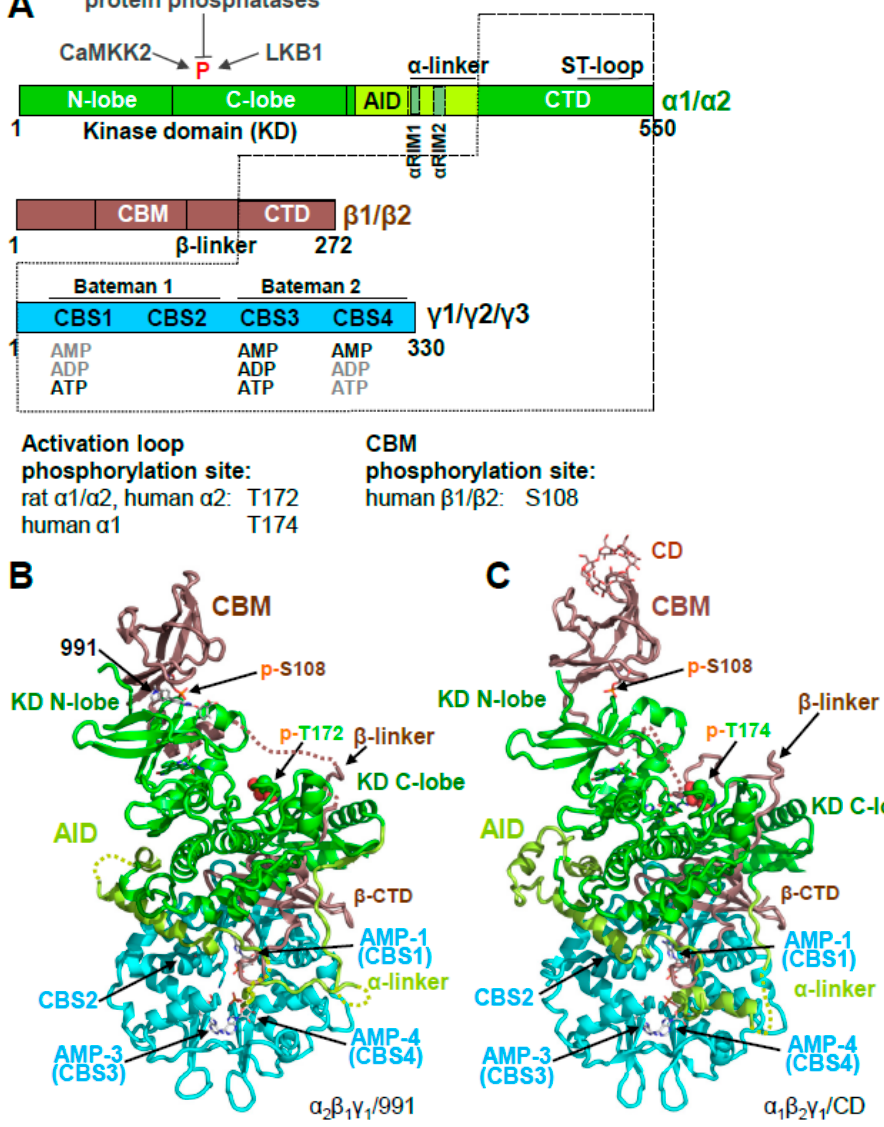
Figure 1. Overall structure of human adenosine monophosphate (AMP)-activated protein kinase (AMPK). ( A ). Domain structure and AMPK isoforms. Activation loop and carbohydrate-binding module (CBM) phosphorylation sites of different isoforms are indicated below the domain map ( B , C ). Crystal structures of phosphorylated, AMP-bound AMPK α 2 β 1 γ 1 /991 (( B ); PDB: 4CFE) and α β γ 1 2 1 /cyclodextrin (CD) (( C ); PDB: